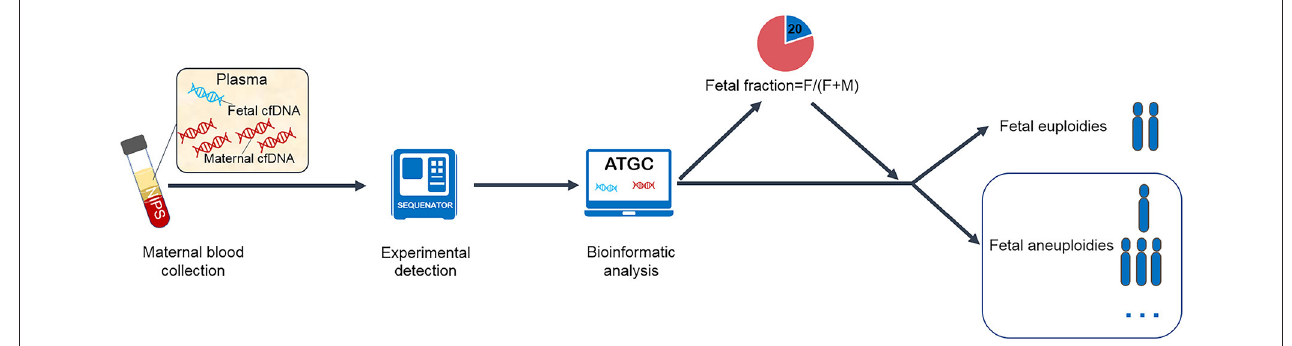
FIGURE 1 | Flow chart of noninvasive prenatal